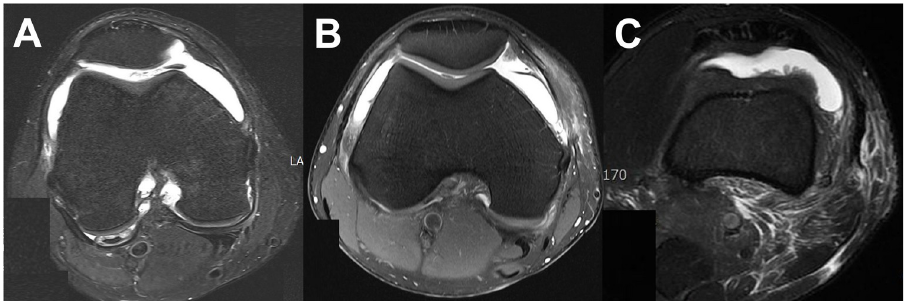
Fig 1. The severity of soft tissue injury. (A) Grade 0, none to minimal injury. (B) Grade 1, injury superficial to fascia. (C) Grade 2, injury deep to